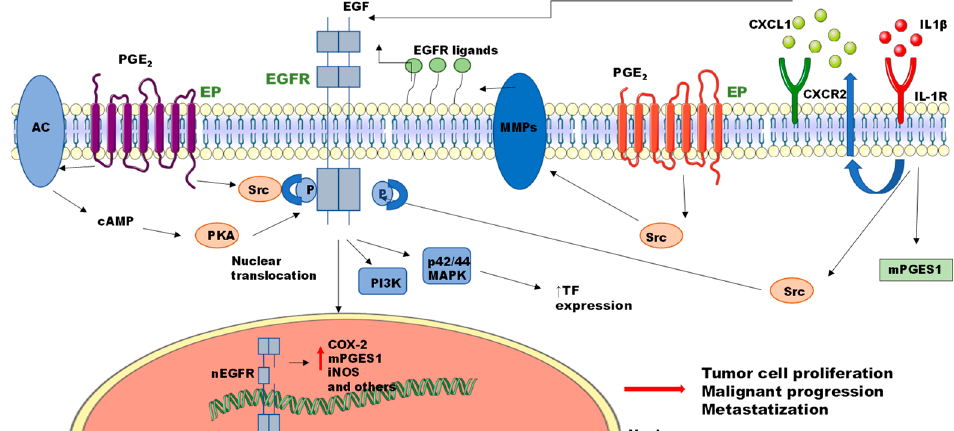
Figure 3. Crosstalk between PGE2 and EGFR. PGE2 promotes EGFR phosphorylation and internalization through the activation of different signaling pathways. PGE2 promotes EGFR phosphorylation either by EP-mediated Src or PKA activation, or by inducing the release of EGFR ligands (MMPs activation). Similarly, IL-1 β signaling promotes EGFR activation through the increased production of CXCL1, which in turn activates EGFR through CXCR2, or by a Src-mediated mechanism. AC = adenylate cyclase; PGE2 = prostaglandin E2; EP = prostaglandin E2 receptor; cAMP = cyclic adenosine monophosphate; PKA = protein kinase A; Src = SRC proto-oncogene; EGFR = epidermal growth factor receptor; nEGFR = nuclear EGFR; EGF = epidermal growth factor; PI3K = phosphatidylinositol 4,5-bisphosphate 3-kinase; p42/44 MAPK = p42/44 mitogen-activated protein kinases; TF = tissue factor; MMPs = matrix metalloproteinases; IL-1 β = interleukin 1 β ; CXCR2 = CXC motif chemokine receptor 2; CXCL1 = C-X-C motif chemokine ligand 1; COX-2 = cyclooxygenase 2; mPGES1 = microsomal prostaglandin E synthase 1; iNOS = inducible nitric oxide synthase.